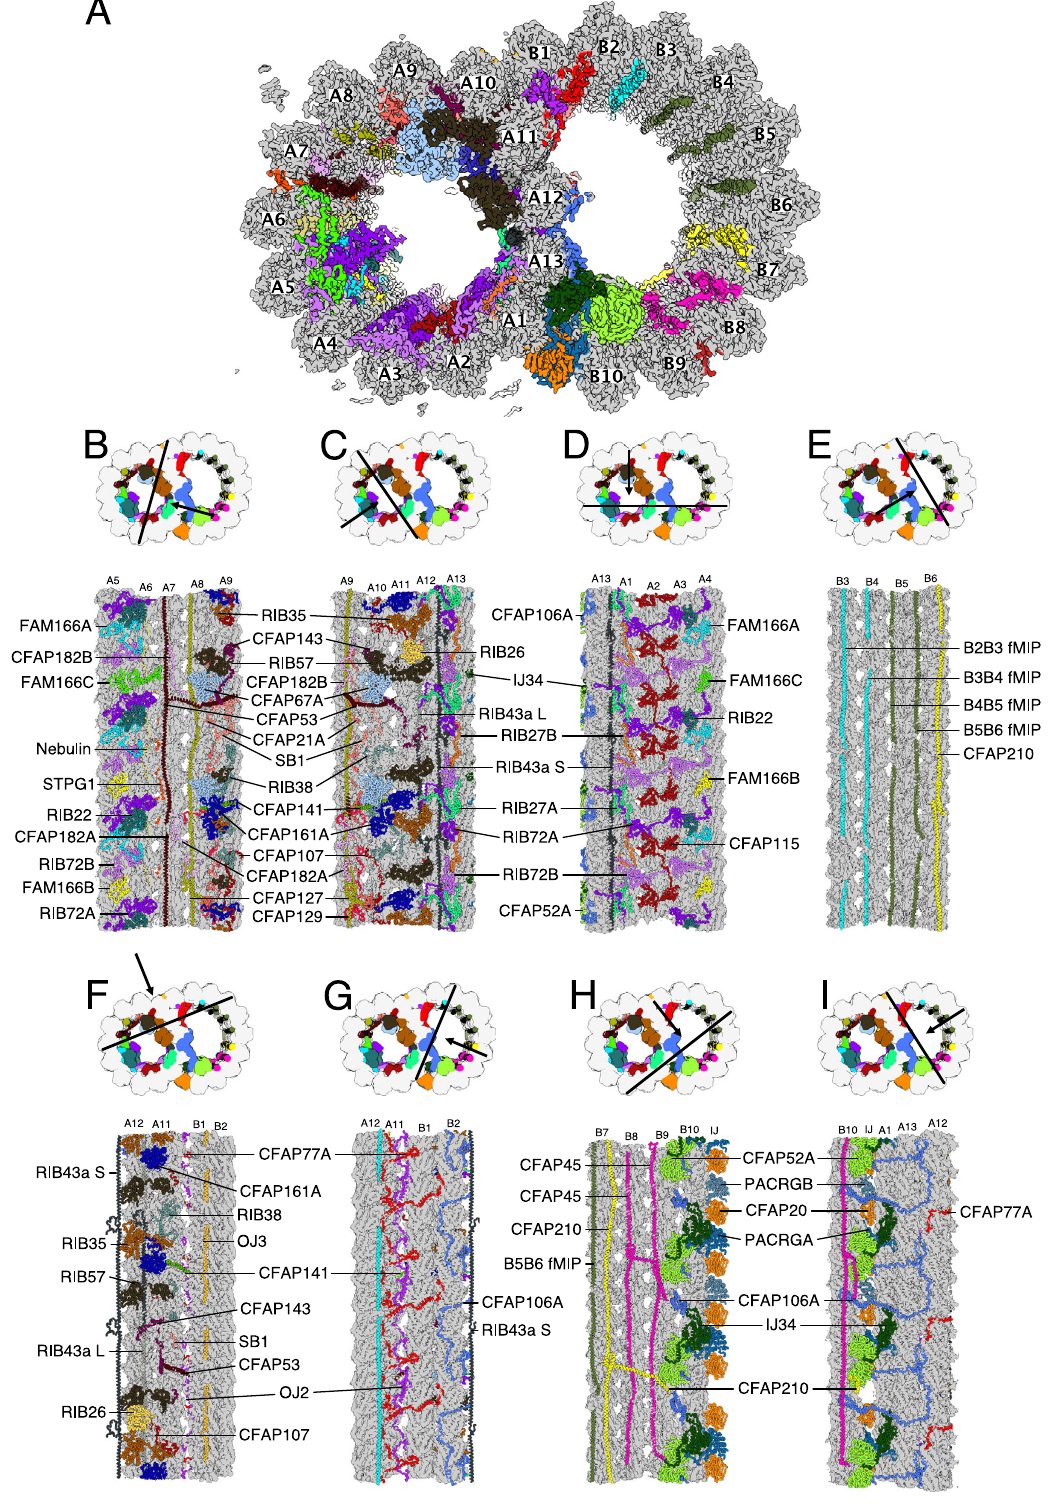
Fig.1|ThestructureofthenativeDMTfrom Tetrahymenathermophila .A Across-sectionoftheDMTmap.EachcolordenotesanindividualMIP.Tubulinsareingray. B – I Views of the lumen of the DMT from different angles as indicated by the black arrow. The cutting plane indicated by black